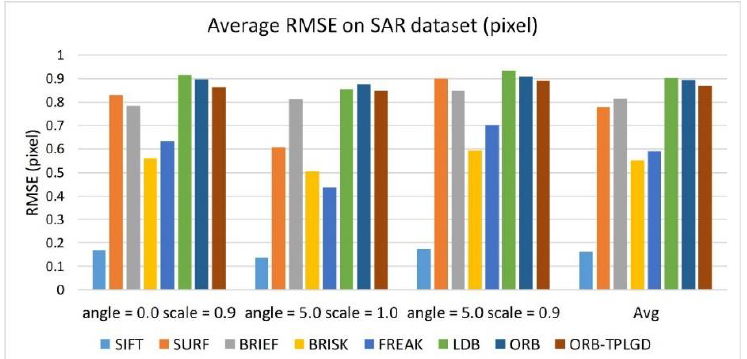
Figure 14. Average time required of test algorithms in the case of these three image transformations. Figure 14. Average RMSE of test algorithms in the case of these three image